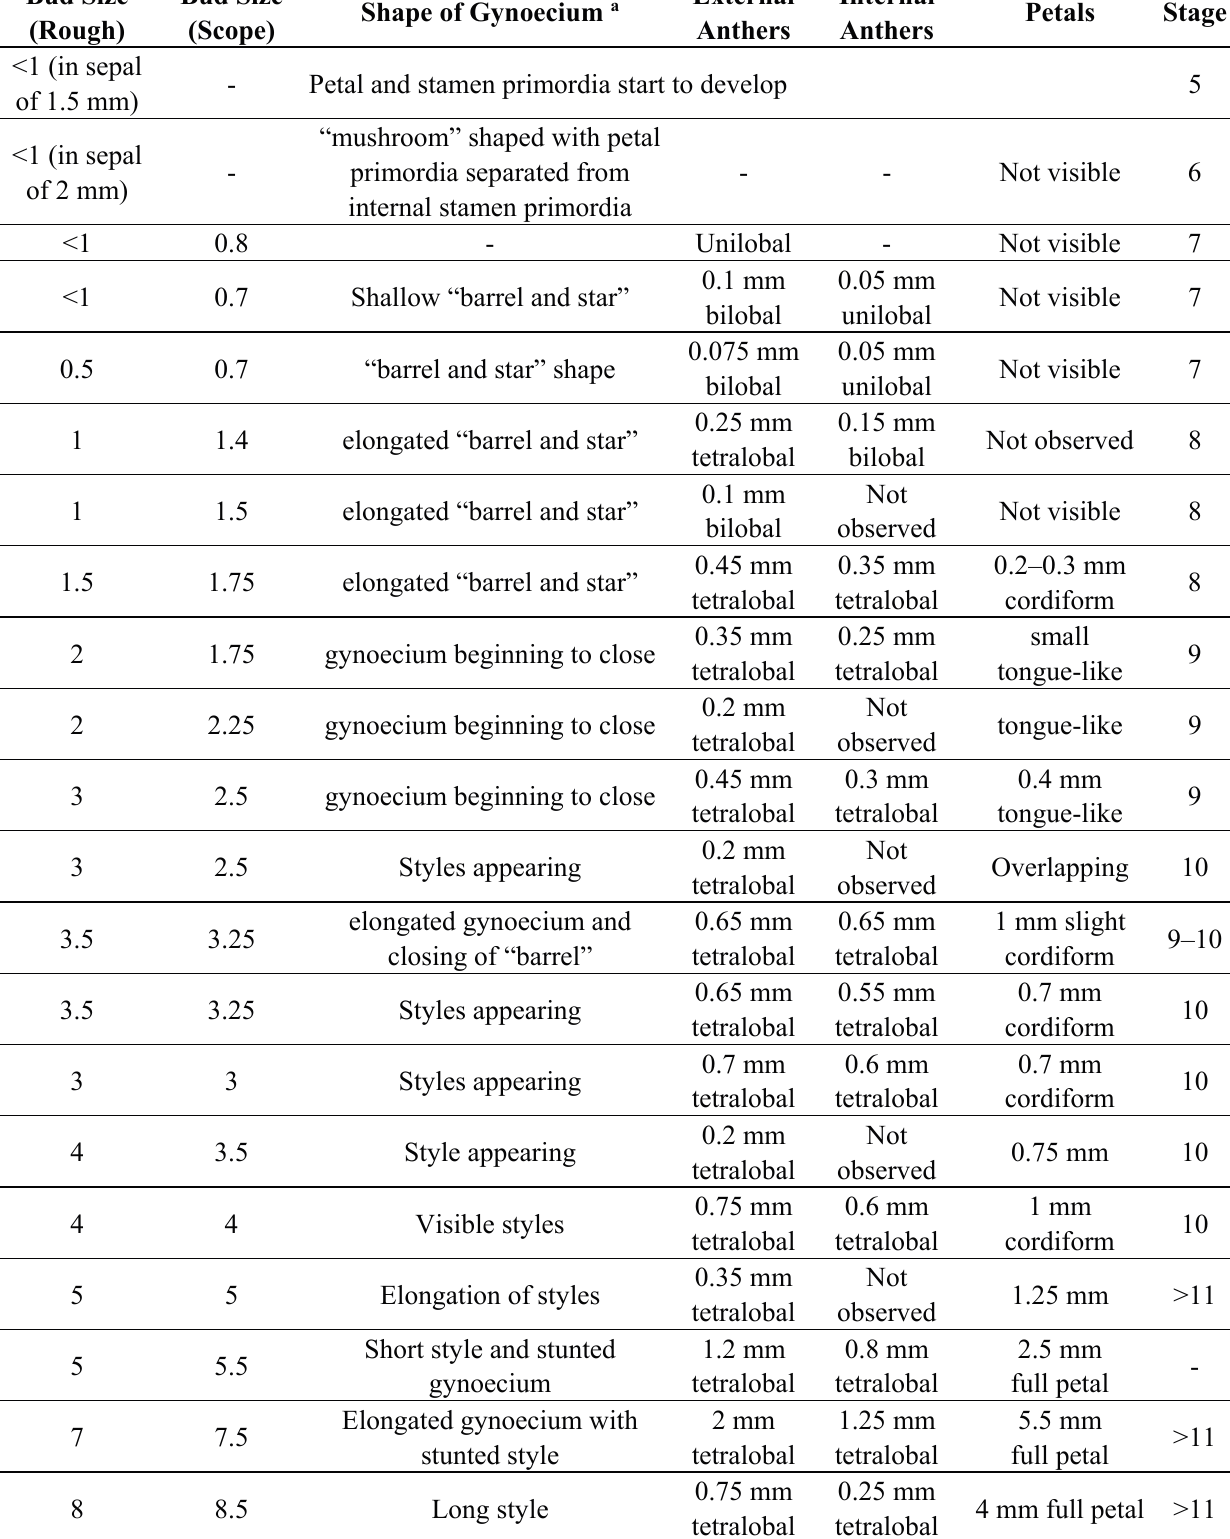
Table 1. Size observation and staging of female infected floral buds from two